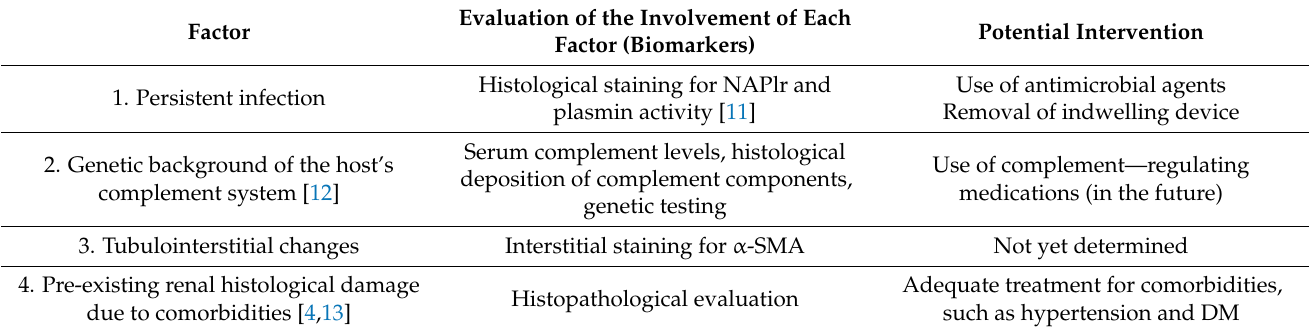
Potential Intervention